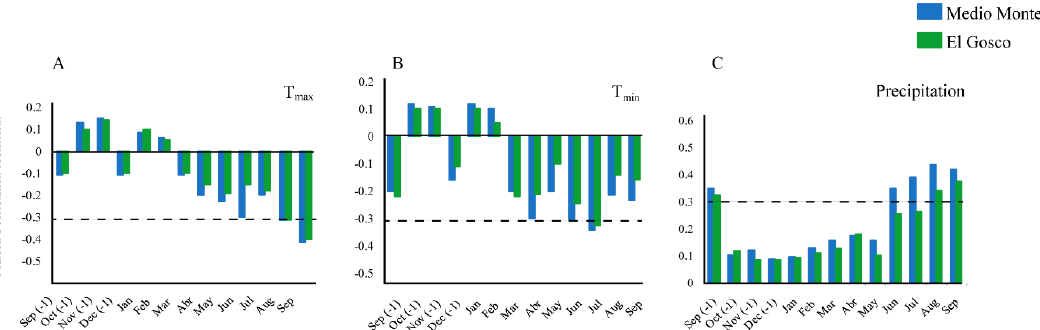
Figure 5. Correlations between chronologies against the mean maximum temperature ( A ), mean minimum temperature ( B ) and monthly precipitation ( C ) for each drought year (DY) (September ( − 1) to September) from the year 1941 onward. Horizontal dashed lines indicate the significance intervals ( p < 0.05) for correlation coefficients. ( − 1) show the previous years and (+1) the following years in which growth started.